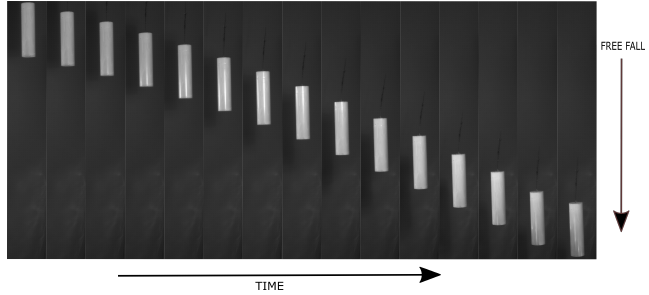
Figure 7. Sample images of free-falling object from